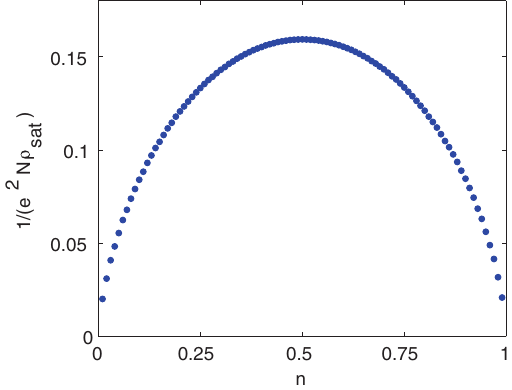
Fig. 4 Saturation resistivity, ρ sat , as a function of the density of electrons per site per fl avor